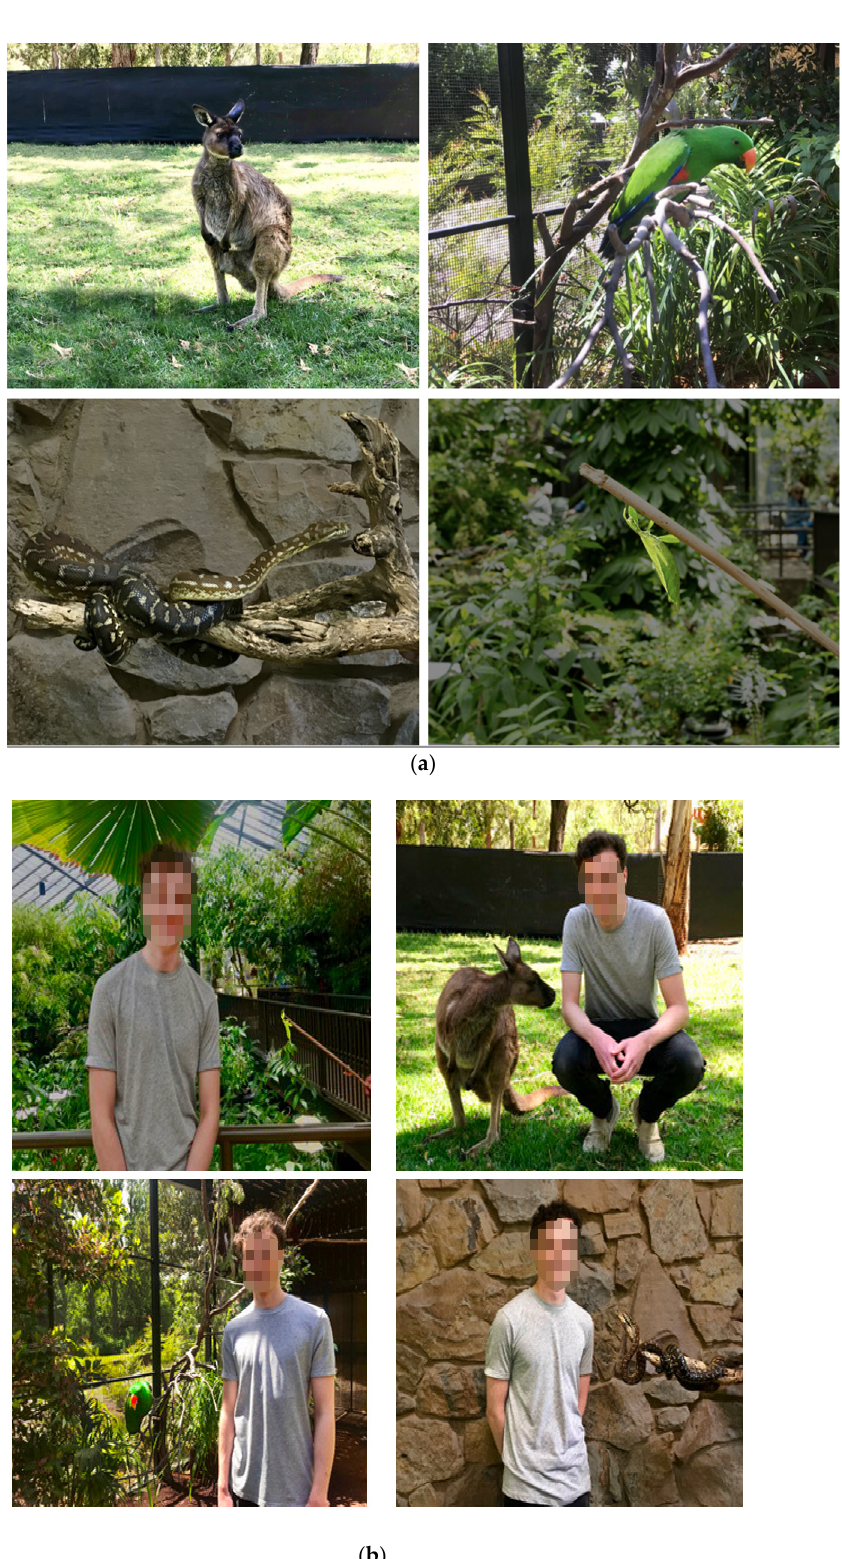
Figure 1. ( a ) The four Featured Animals, photographed with no human present, and ( b ) the four Featured Animals, photographed with the human ~30 cm from the animal.